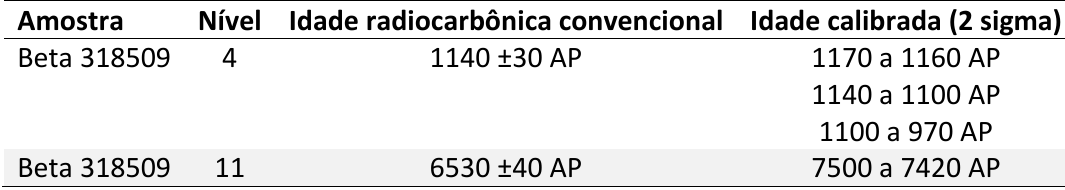
Table 1. C 14 dated samples from the Abrigo do Alvo